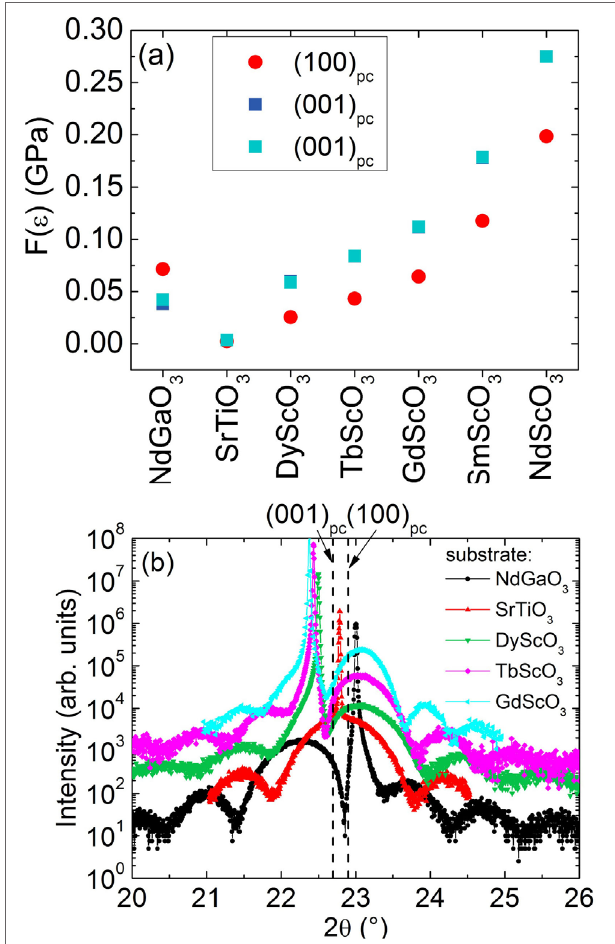
FigUre 3 | (a) Calculated elastic strain energy density F( ε ) for (100) pc and (001) pc surface orientation of NaNbO 3 films grown on different substrates. (b) High-resolution X-ray diffraction θ /2 θ scans of 10 nm thick NaNbO 3 films on the different substrates. The dashed lines indicate the positions for unstrained NaNbO 3 .